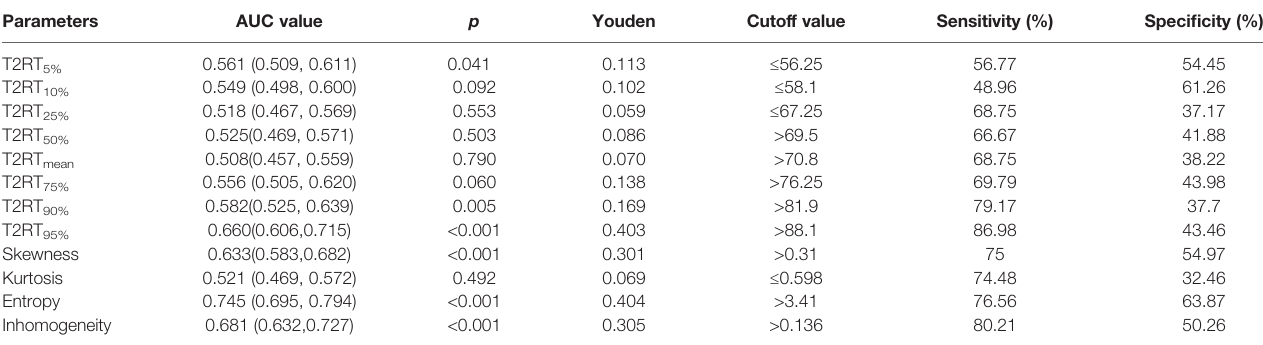
TABLE 2 | The ROC of the T2RT histogram